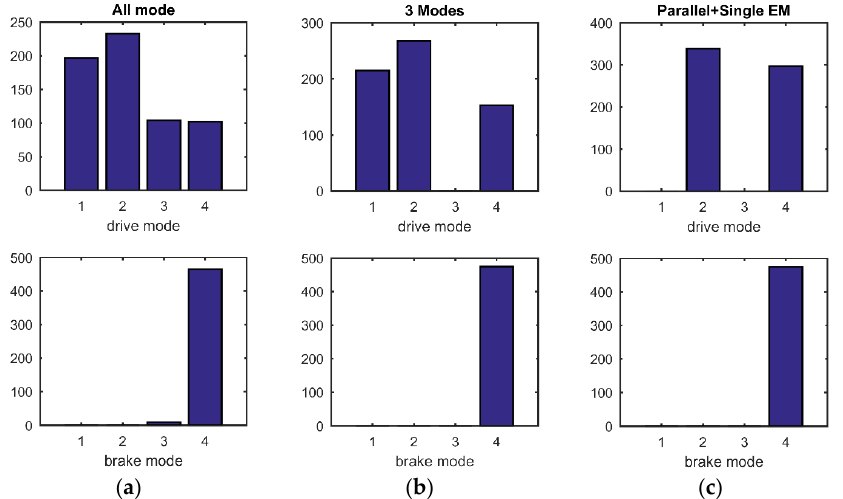
Figure 19. Frequency of mode utilization in three different configurations over the UDDS driving cycle: ( a ) All Mode Configuration; ( b ) 3 Modes Configuration; ( c ) Parallel + Single EM Configuration.